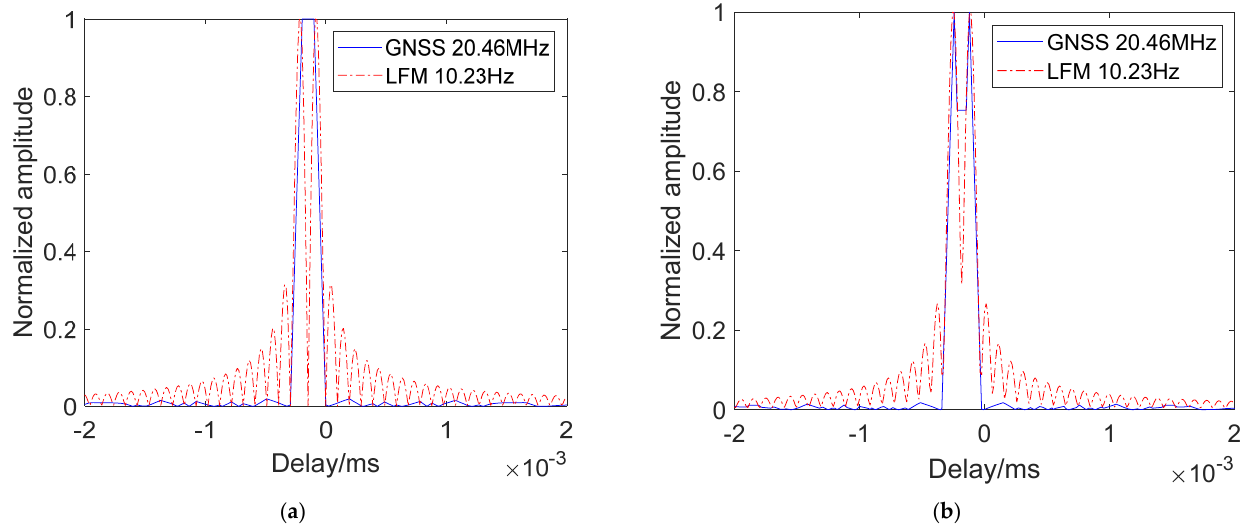
Figure 4. Two-point target detection main lobe curves of GNSS B3I and chirp signals: ( a ) The distance between the two targets is 29 m; ( b ) the distance between two targets is 33 m.